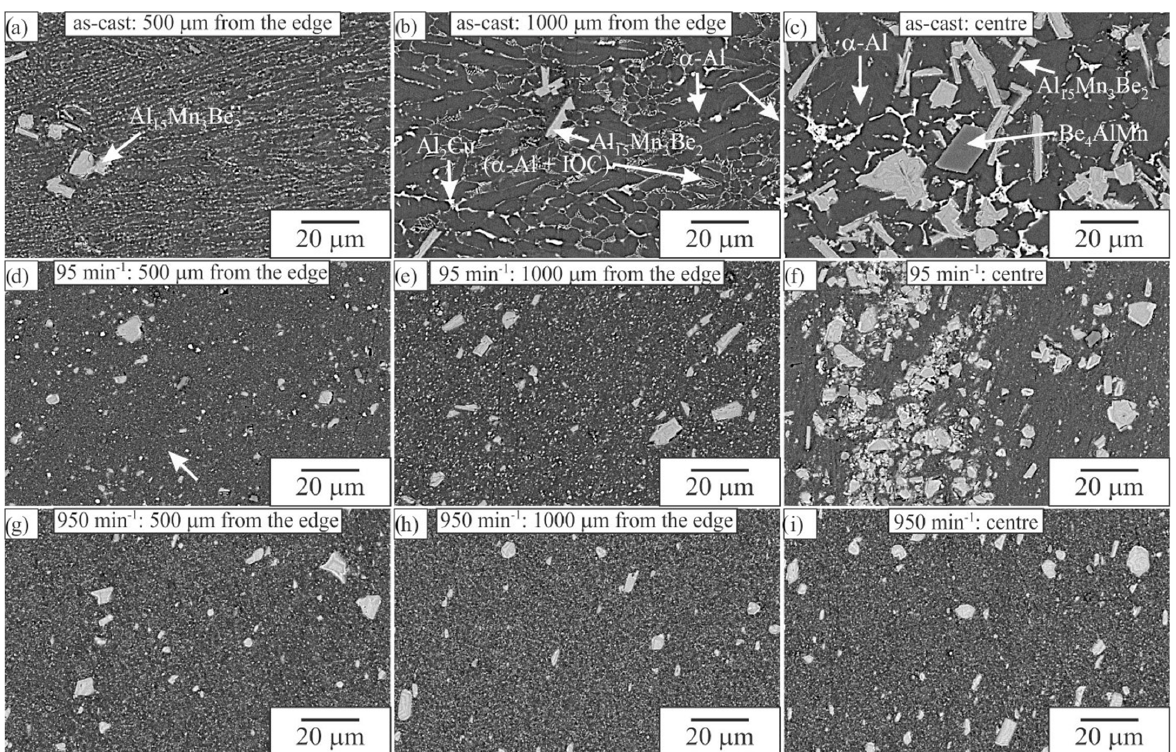
Figure 3. The backscattered electron micrographs of ( a – c ) the twin-roll cast strip; ( d – f ) sample FSP95, and ( g – i ) sample FSP950.